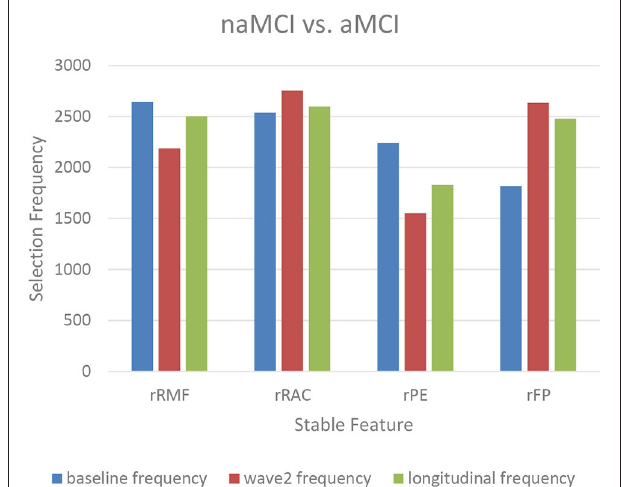
FIGURE 4 | The selection frequencies of the stable features for naMCI vs. CN classification. The baseline, wave-2 or longitudinal frequency are the selection frequencies of the feature measured at baseline, wave-2 or longitudinally, respectively. The selection frequency (between 0 and 3,000) of each feature is indicative of the discriminative power for classification. Volume of left temporal pole is a more important biomarker in former time point. When measured longitudinally, volume of right rostral anterior cingulate and thickness of right middle frontal are not selected in the first 10 feature list. The right amygdala volume is stable over time. lTP, left temporal pole volume; rA, right amygdala volume; rRAC, right rostral anterior cingulate volume; rRMF, right rostral middle frontal thickness.